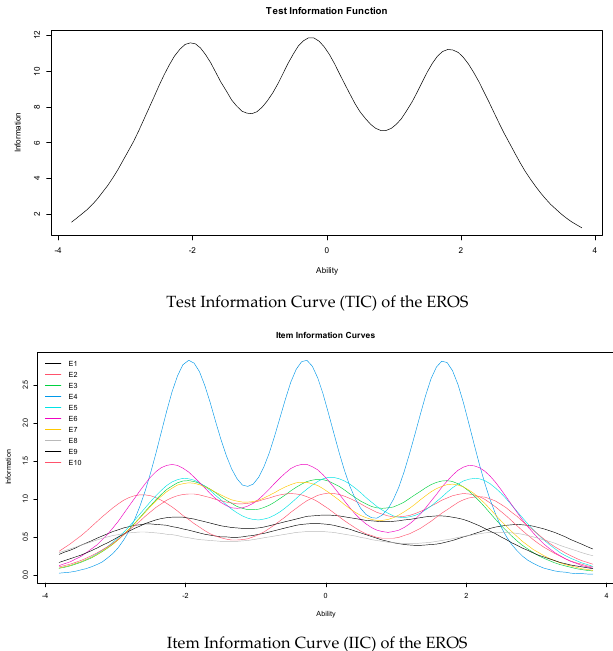
Figure 2. Item and test information curves.